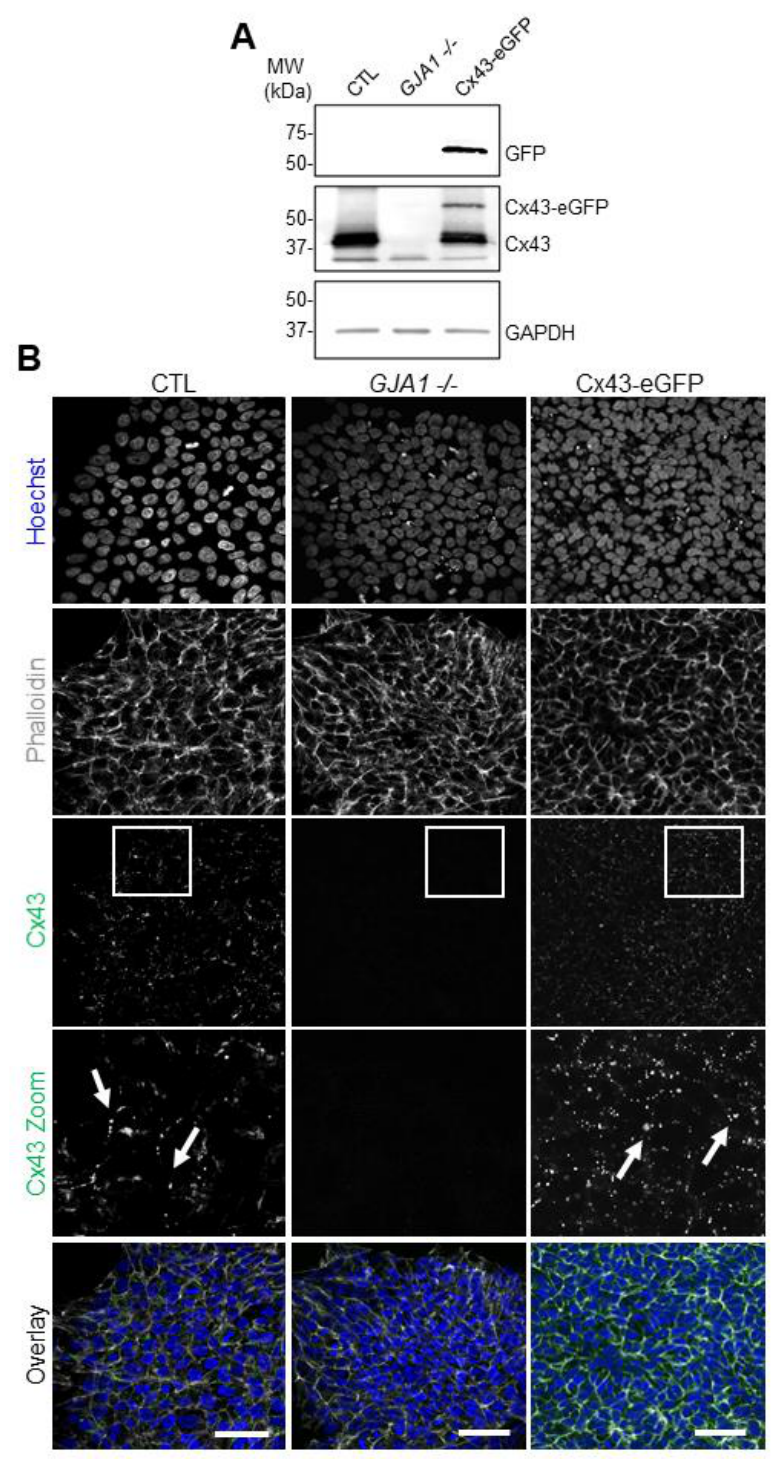
Figure 3. CRISPR-Cas9 manipulation of Cx43 ( GJA1 ) in human iPSCs. ( A ) Representative Western blots of green fluorescence protein (GFP), Cx43, and GAPDH in control, Cx43 knockout ( GJA1-/- ), and Cx43eGFP iPSCs. ( B ) Immunofluorescence confocal microscopy of Cx43 (green) in control, GJA1-/- , and Cx43-eGFP iPSCs. Actin (phalloidin, grey); nuclei (Hoechst, blue). Cx43 forms large puncta (white arrows) at the cell surface indicative of gap junction plaques. Scale bars = 50 µm.